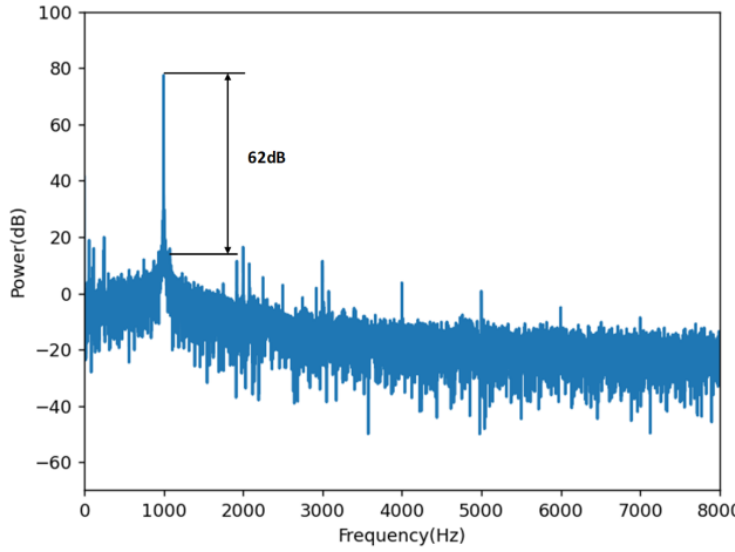
Figure 5. Demodulation results at different frequencies: ( a ) the demodulated signal of 400 Hz, ( b ) the demodulated signal of 1 KHz, ( c ) the demodulated signal of 2 KHz.